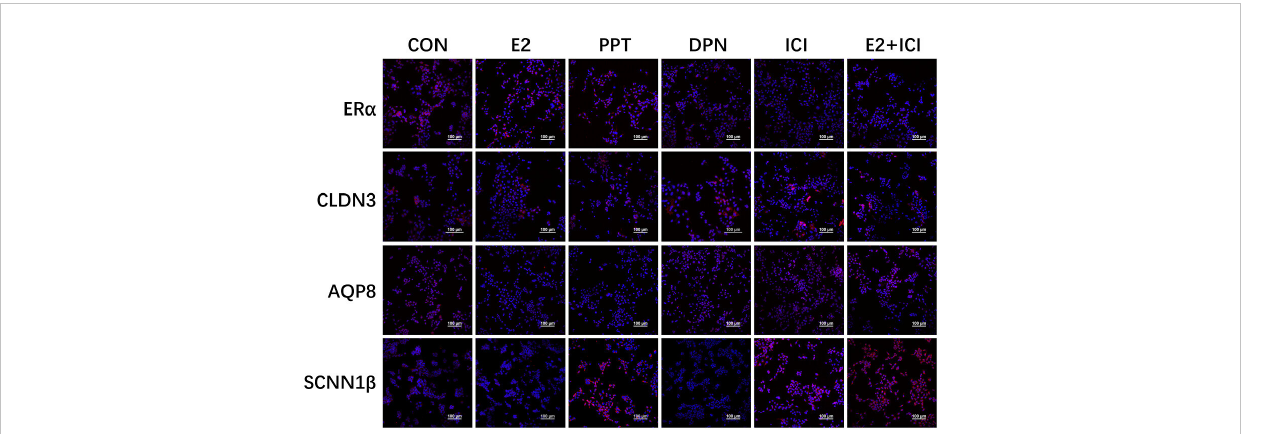
FIGURE 5 Localization of ER a , CLDN3, AQP8, and SCNN1 b in RL95-2 cell line. CON: control group, E2: treat with 10 -6 M oestrogen, PPT: treat with 10 -6 M ER a agonist, DPN: treat with 10 -6 M ER b agonist, ICI: treat with 10 -6 M oestrogen receptor antagonist, E2+ICI: treat with both 10 -6 M E2 and 10 -6 M ICI. The blue colour: nucleus stained by DAPI. The red colour: localization of target